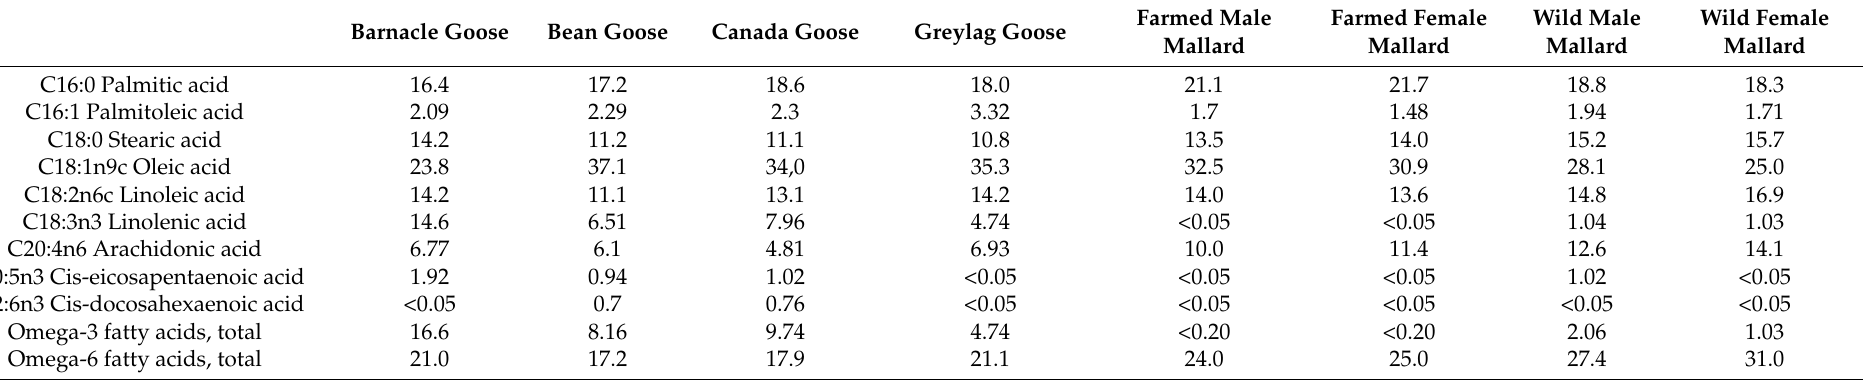
Table 3. A selection of relevant fatty acids in grams per 100 g of fat for all four species of goose, as well as for farmed and wild mallards of both sexes. The values represent mean values based on pooled samples of six breast muscles from each